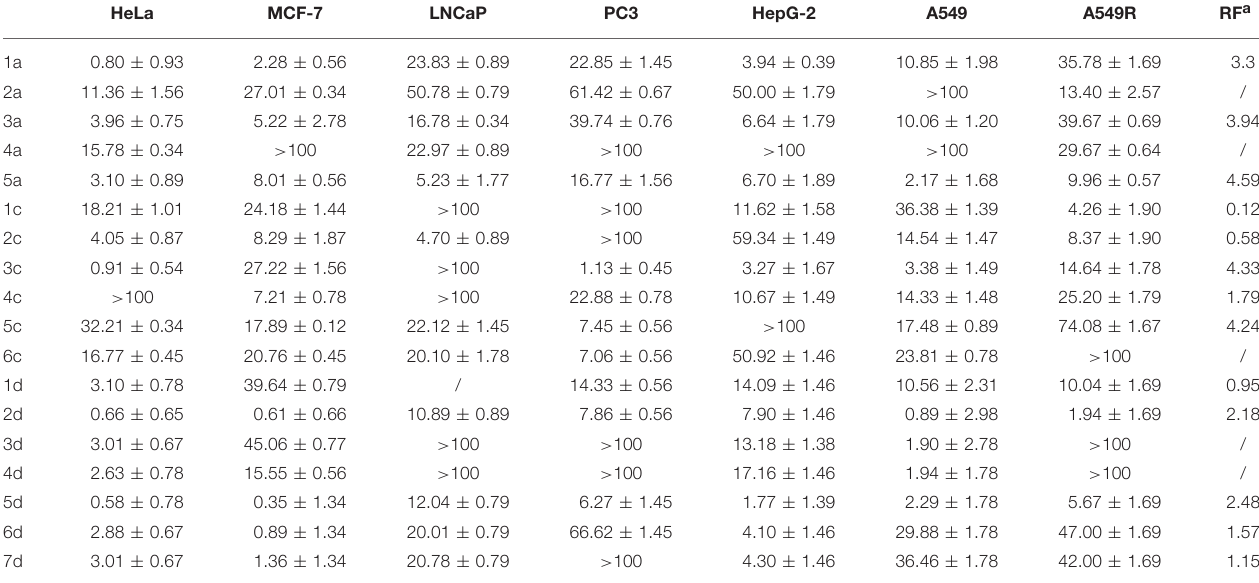
TABLE 1 | Cytotoxicity profiles of glycosylated Pt(IV) complexes (IC 50 in µ M) in seven human carcinoma cell lines. HeLa MCF-7 LNCaP PC3